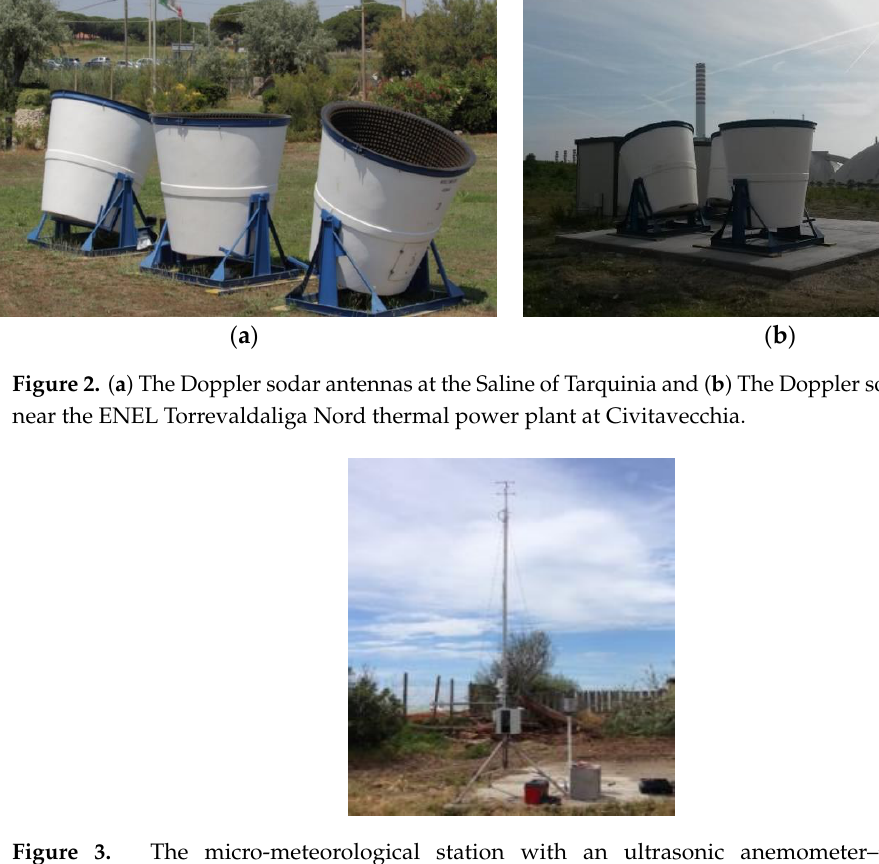
Figure 3. The micro-meteorological station with an ultrasonic anemometer–thermometer, thermo-hygrometer, net-radiometer, barometer, and pluviometer. The instrumentation is specified in Table 1.